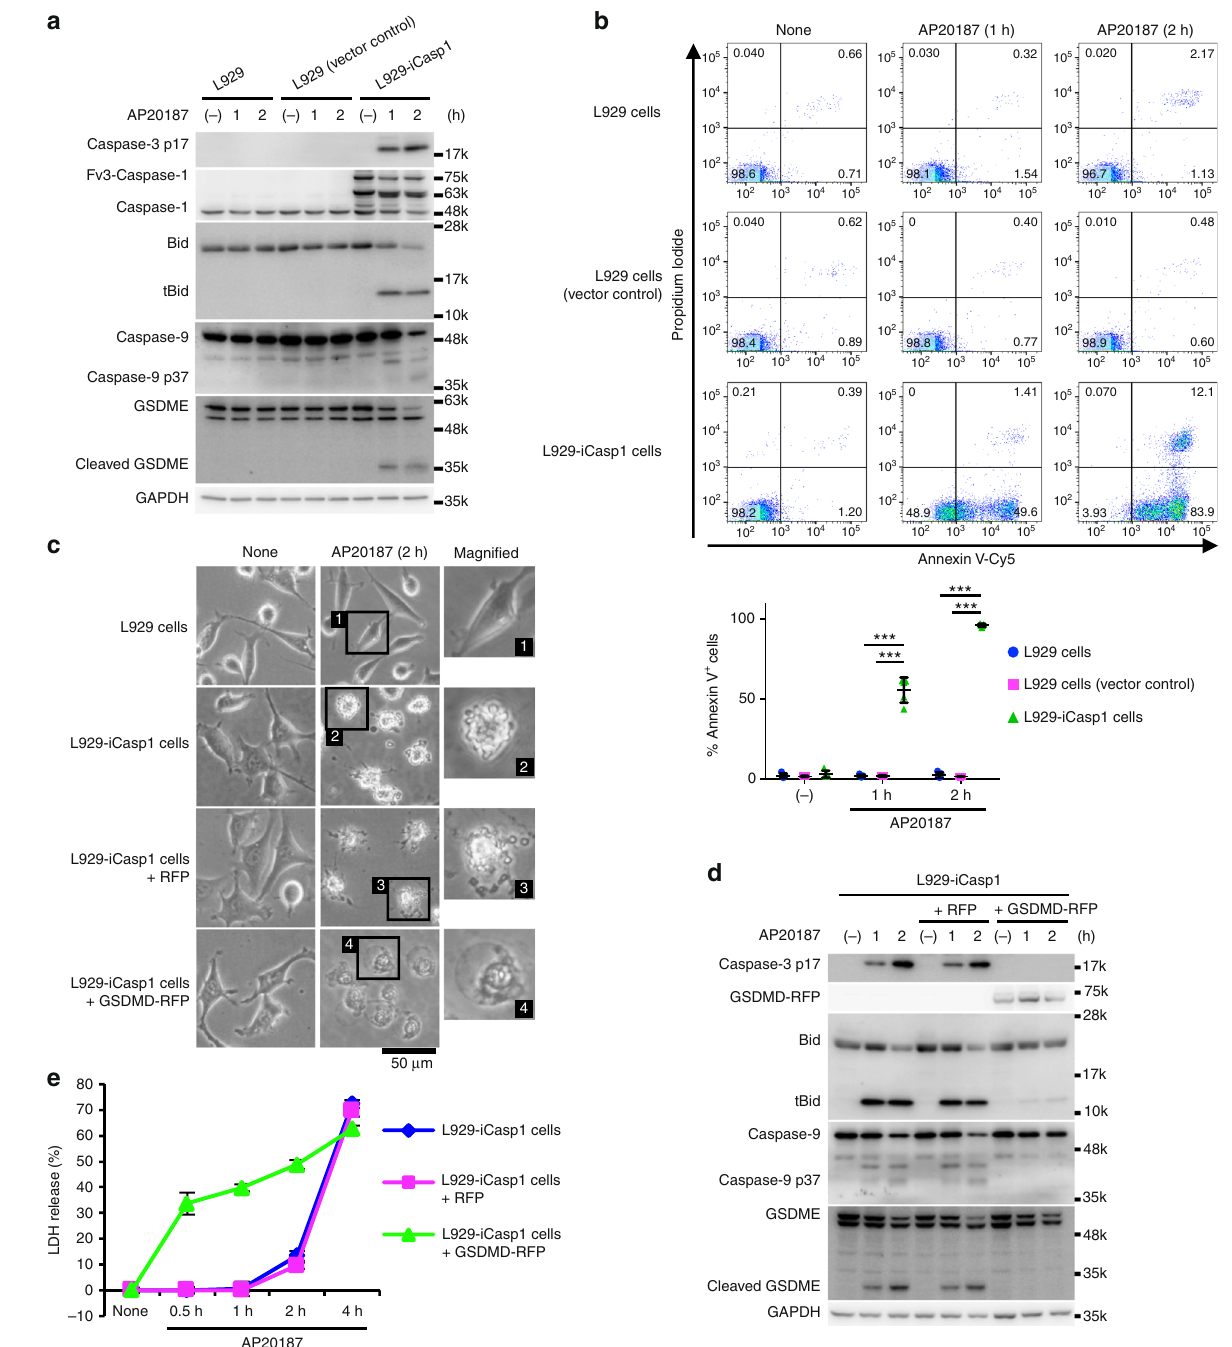
Fig. 9 Caspase-1 induces apoptosis in L929 cells. a , b L929 cells, L929-vector control cells, and L929-iCasp1 cells were treated with 50 nM AP20187 for the indicated times. Caspases, Bid, and GSDME were detected by Western blotting ( a ). Flow cytometric analysis of PI uptake and PS exposure ( b ). Representative fl ow cytometry pro fi les and the graph that shows percentages of Annexin V + cells ( n = 5) from two independent experiments are shown. Horizontal and vertical bars indicate the mean ± SD. c – e L929-iCasp1 cells were transduced or not transduced with red fl uorescent protein 657 (RFP) or GSDMD-RFP, and then treated with AP20187 for the indicated times. Microscopic images ( c ). Caspases, GSDMD, GSDME, and Bid were detected by Western blotting ( d ). LDH release ( e ). The graph depicts the mean ± SD of triplicate cultures. In b and e , statistical signi fi cance was determined using the Bonferroni ’ s multiple comparisons test. *** p < 0.001. In a and c – e , data are from one representative three independent experiments with similar results. Source data are provided as a Source Data fi le. (See also Supplementary Fig.